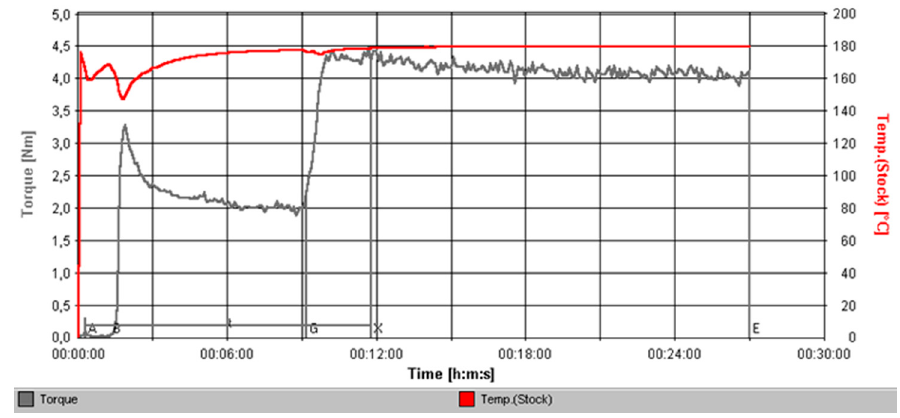
Figure 4. Torque evolution over time during mixing (critical powder volume concentration (CPVC) = 60 vol %).